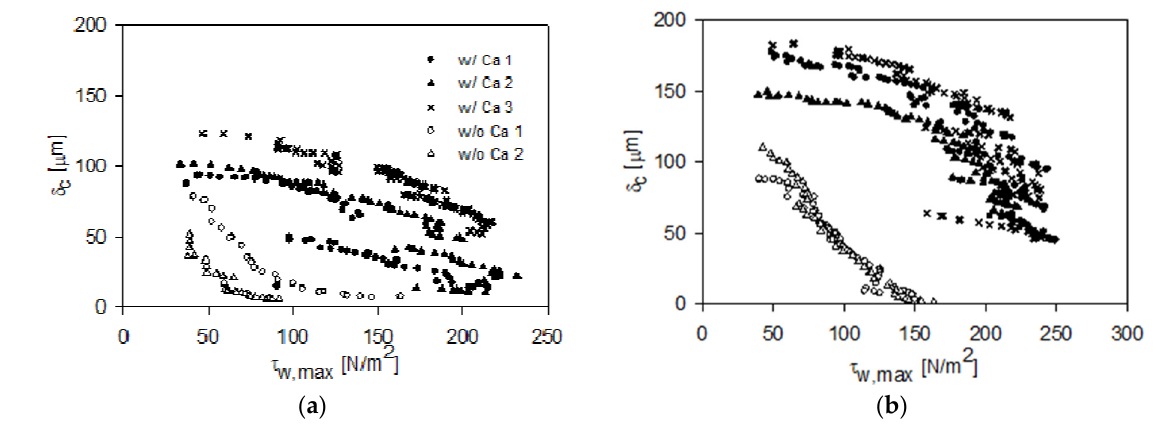
Figure 6. Plot of estimated cake height vs. applied maximum shear stress for fouling layers formed by low surface charge ( a ) and high surface charge ( b ) PS–PAA microparticles in the presence and absence of calcium ions. Shear stresses above 214 N/m 2 were based on h -values estimated using an extrapolation of Equation (1).